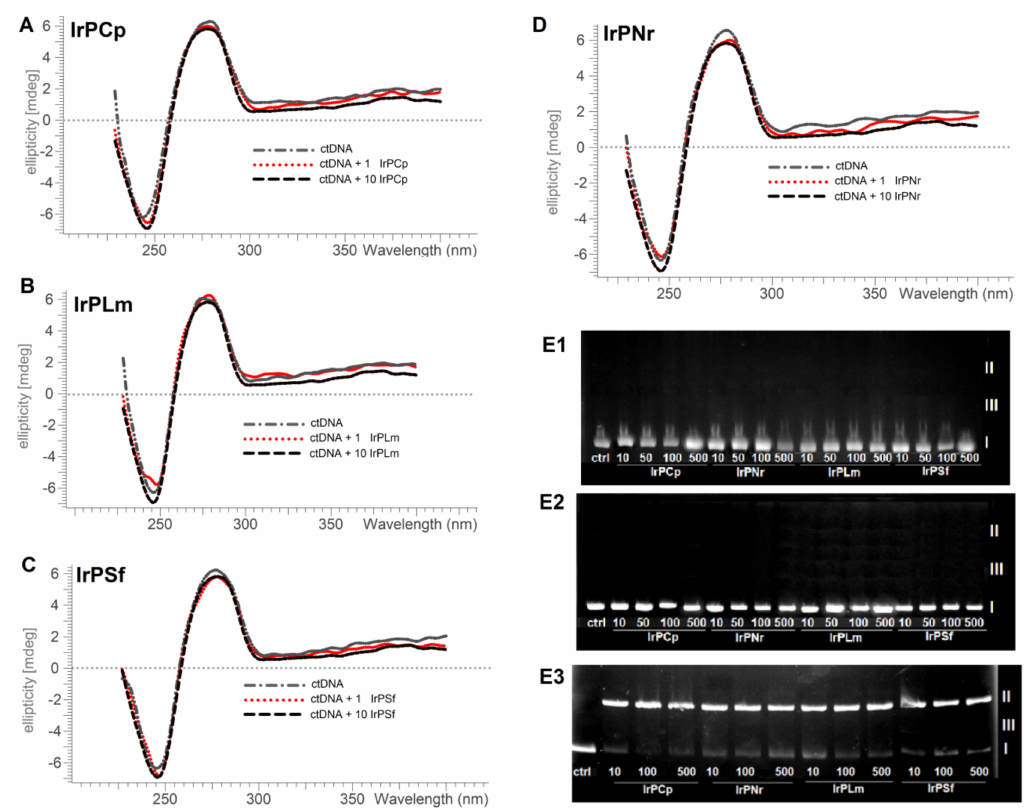
Figure 4. Circular dichroism spectra of CT DNA with: ( A ) IrPCp ; ( B ) IrPLm ; ( C ) IrPSf ; ( D ) IrPNr ; ( E ) agarose gel electrophoresis of pBR322 plasmid cleavage by IrPCp , IrPSf , IrPLm and IrPNr in a DMF (each in the 10% DMF) solution, ctrl: plasmid—control. ( E1 ) 1 h of incubation; ( E2 ) 4 h of incubation; ( E3 ) 24 h of